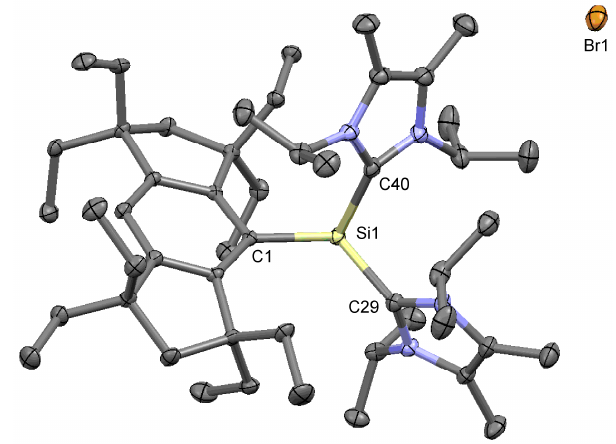
Figure 2. Molecular structure of 3a ′ . The thermal ellipsoids are shown at the 50% probability level. All hydrogen atoms and benzene molecule are omitted for clarity.